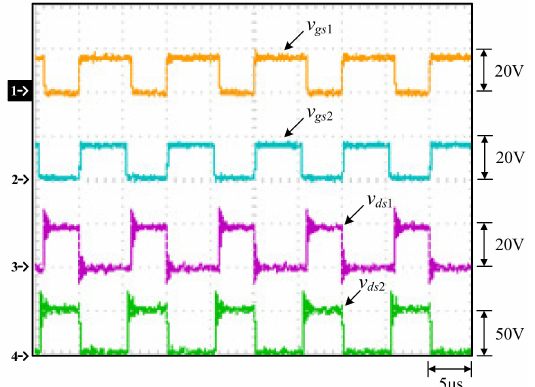
Figure 21. Waveforms measured under the thermoelectric system: (1) v gs 1 ; (2) v gs 2 ; (3) v ds 1 ; (4) v ds 2